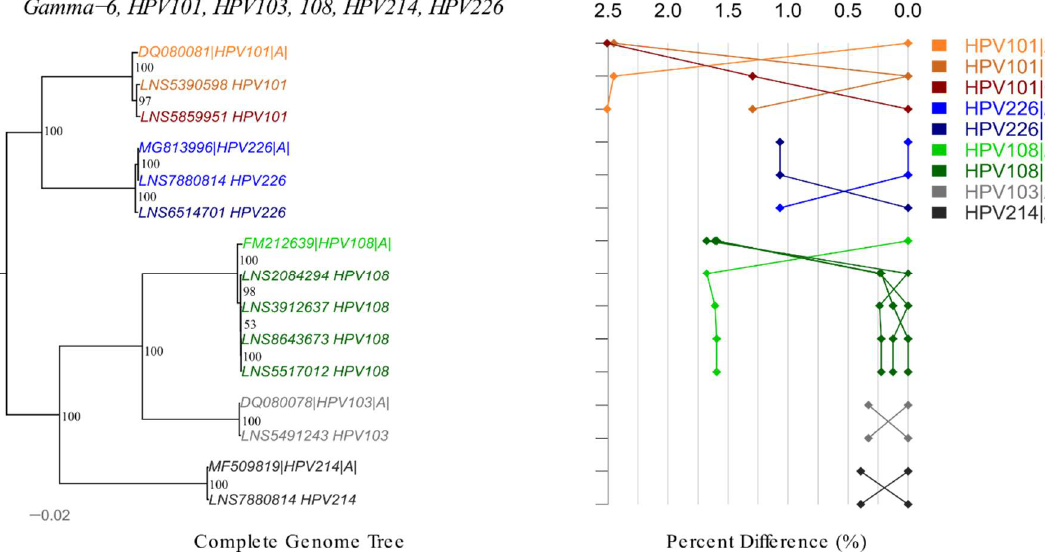
Figure 4. Phylogenetic tree and pairwise distance comparisons for gamma-6 species. Phylogenetic trees were inferred from a global alignment of the complete genome nucleotide sequences of the variants from following HPV genotypes using RAxML: HPV101, HPV103, HPV108, HPV214, HPV226. The phylogenetic topology is shown on the left, pairwise differences for each isolate are shown on the right. Values for each isolate are connected by lines of different colors to distinguish each lineage and sublineage. Genomes from our collection are indicated with LNS identification number.